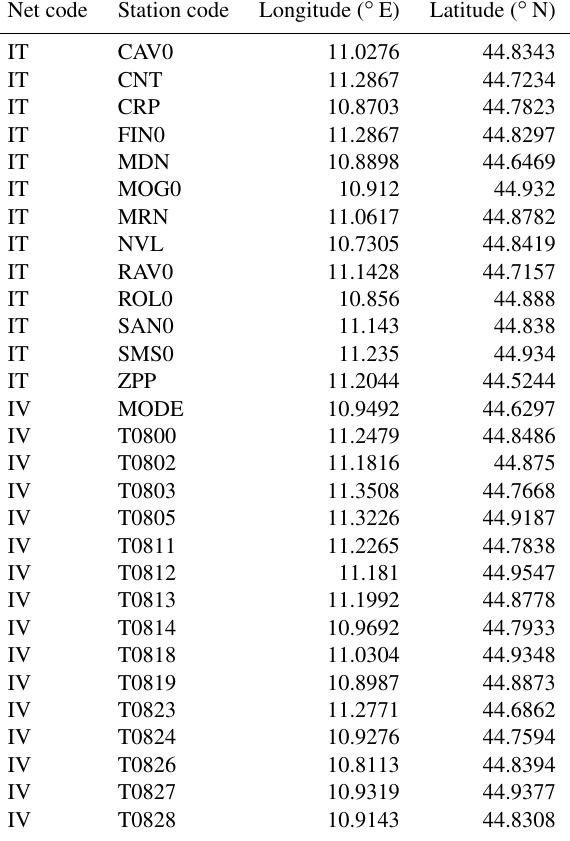
Table 4. List of seismic stations.